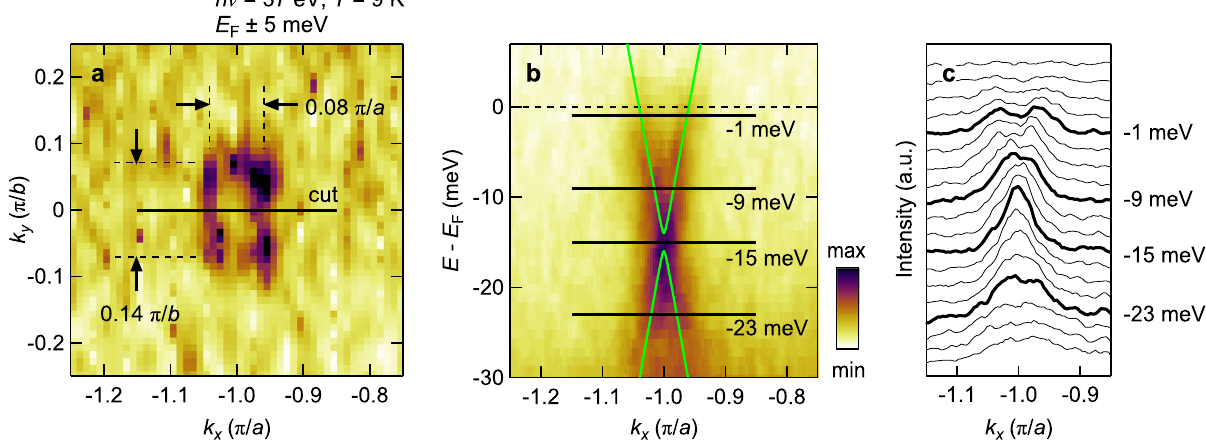
Fig. 4 Dirac cone structure in Ca 3 Ru 2 O 7 . a High-resolution Fermi surface map around the M a point. b Energy distribution map along the M a – Γ direction evidencing a Dirac cone structure. Crystal/magnetic symmetry imposes a fi nite mass as illustrated by green dispersions reproduced by the tight-binding model (see Supplementary Note 1). c MDCs, extracted from b at binding energies as